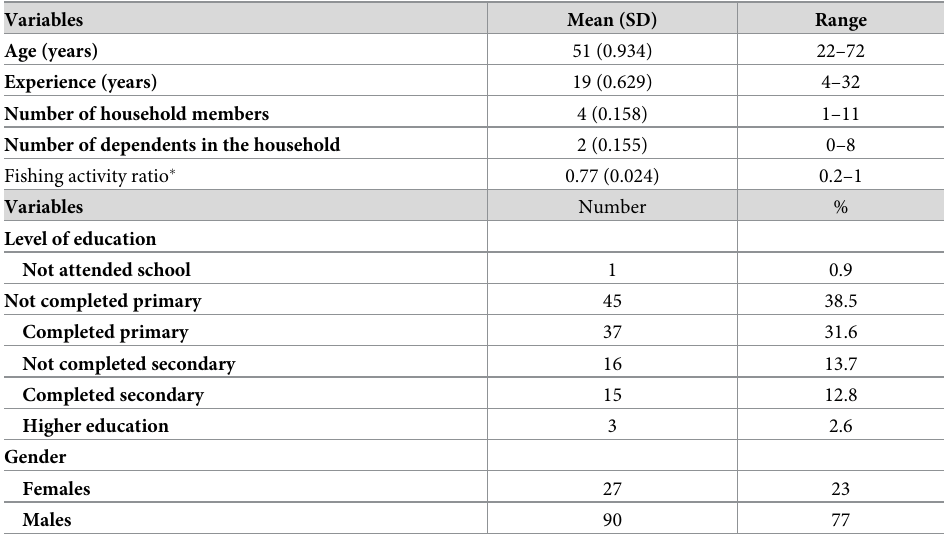
Table 3. Summary of demographic characteristics of fishers’ respondents in Biobio Region.